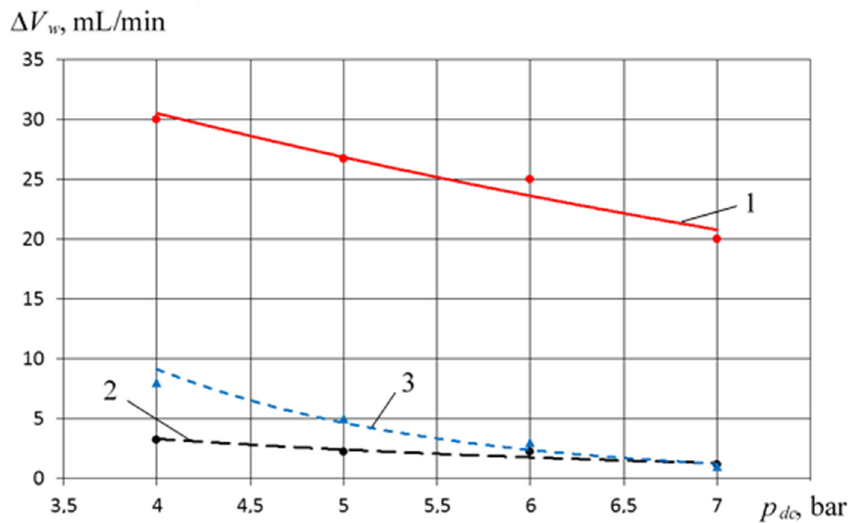
Figure 30. Dependence ∆ V w from the discharge pressure of the compressor section (1—PHPM with step-type gap seals; 2—PHPM with a smooth gap seal; 3—Crosshead-free PHPM).